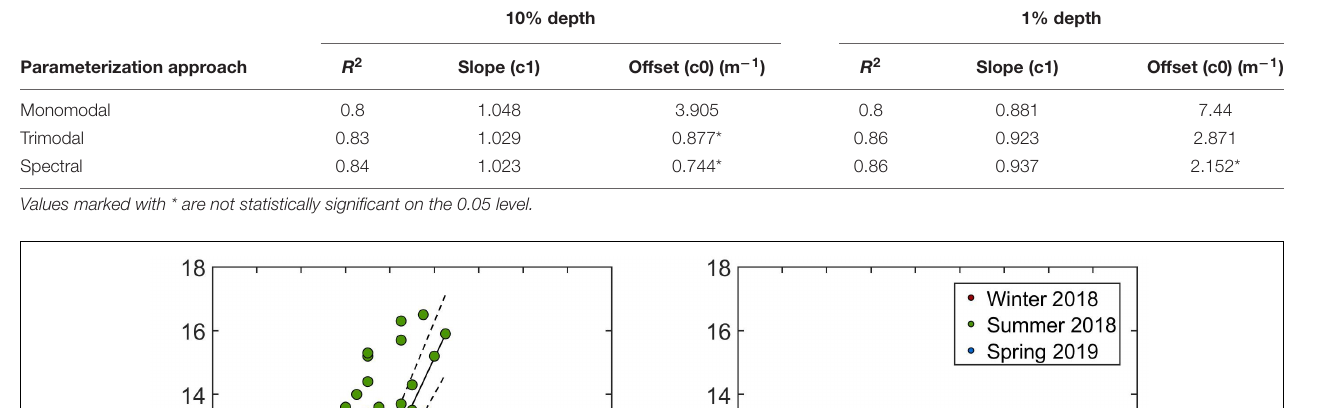
TABLE 4 | Results of linear fits between observed and modeled PAR penetration depths for the different parameterization